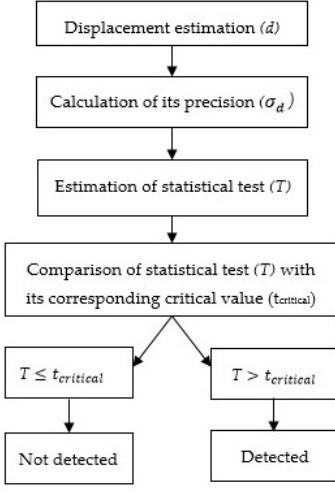
Figure 5. Displacement detection.